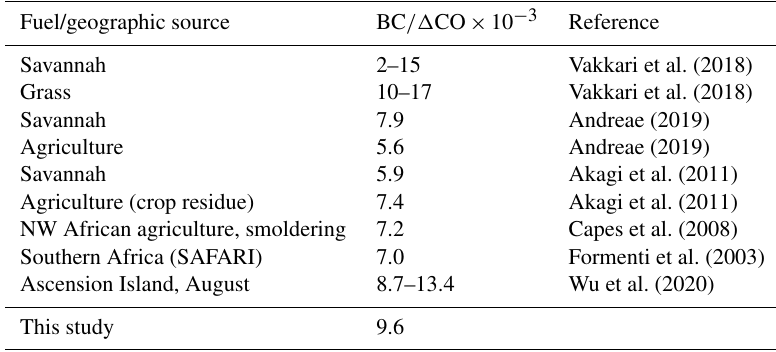
Figure 6. The (a) f 44, (b) OA : BC mass ratio, (c) model-derived time since emission (age), (d) MCE, (e) BC /(cid:49) CO as a non-dimensionalized ratio, and (f) ozone, all for each indicated flight. Whiskers represent the 10th and 90th percentiles, and boxes illustrate the 75th and 25th percentiles, with a line indicating the median and yellow (2017) and blue (2016) filled circles representing the mean. OA > 20µgm − 3 only. Table 2. Comparison to other published BC /(cid:49) CO